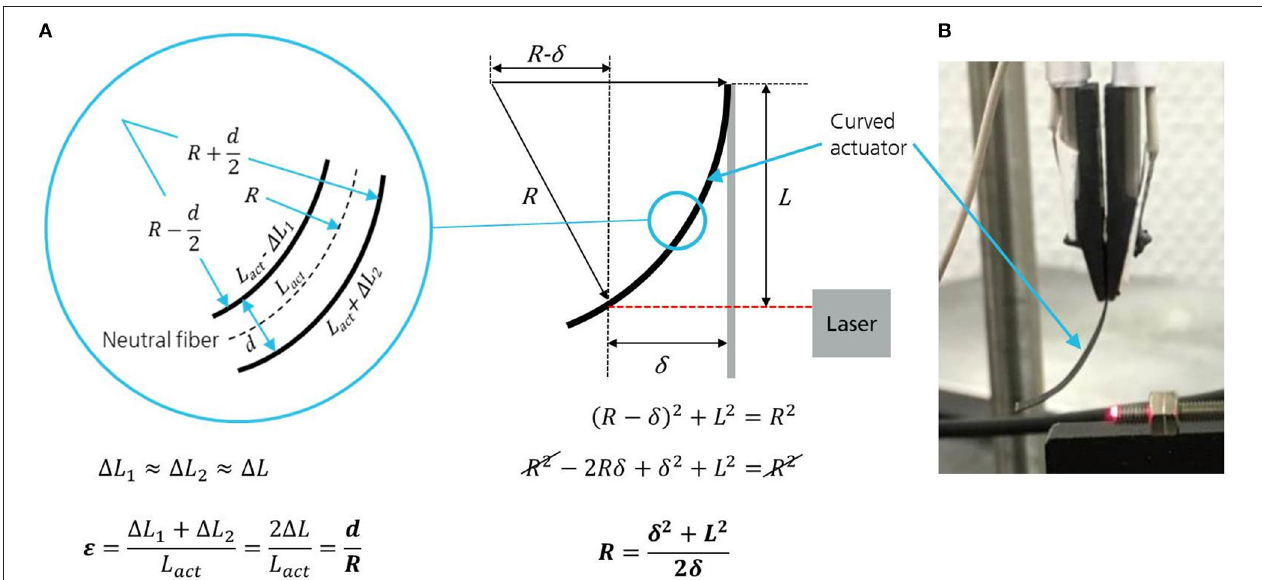
FIGURE 4 | (A) Schematic drawing for explaining the evaluation of the strain from the displacement (B) CNT actuator clamped into the test-setup for performance